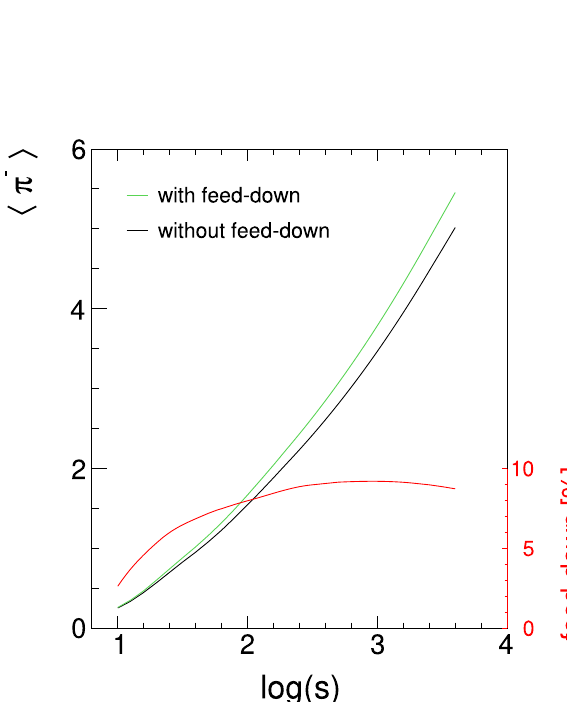
Fig. 149 Total π − yieldsasafunctionoflog ( s ) withandwithoutfeed- down contribution (left scale) together with the feed-down component in percent (right